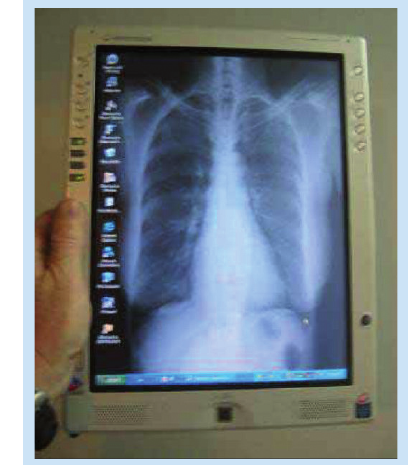
Fig. 2. Tablet PC displaying a chest